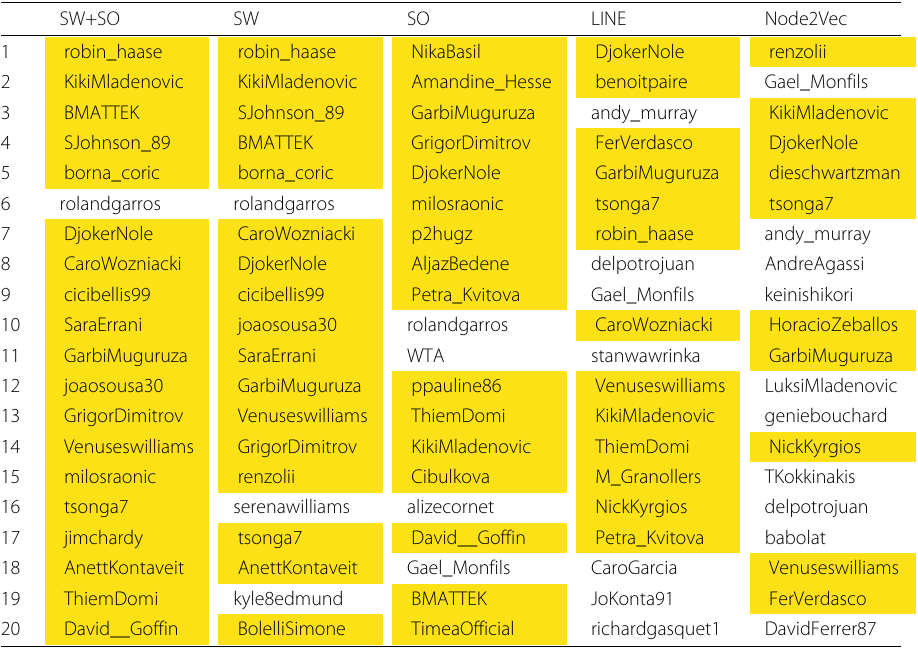
Table 5 Similarity list of Rafael Nadal for models based on embeddings generated at 18:00 on May 31 (fourth day of RG17)